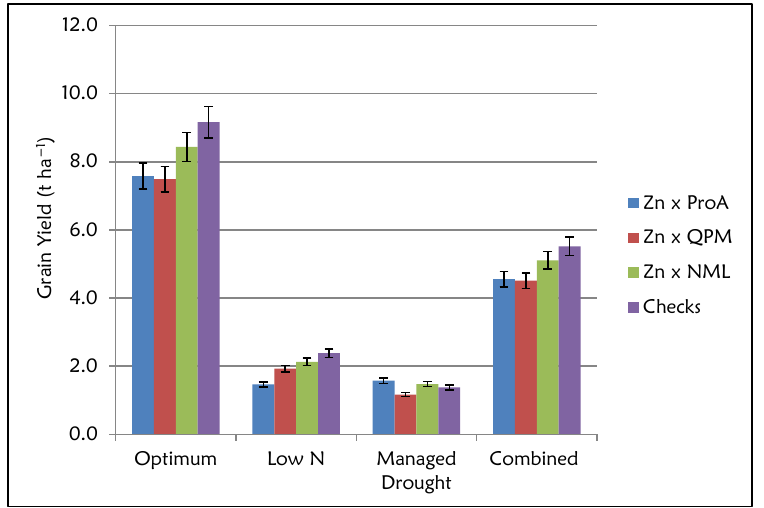
Figure 2. Grain yield performance (t ha − 1 ) for the Zn-enhanced normal (Zn × NML), provitamin A (Zn × ProA) and QPM (Zn × QPM) testcross hybrids and checks evaluated under stress and non-stress environments.